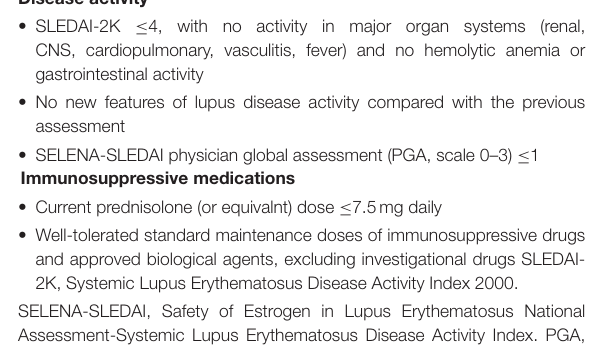
BOX 1 | Lupus low disease activity state